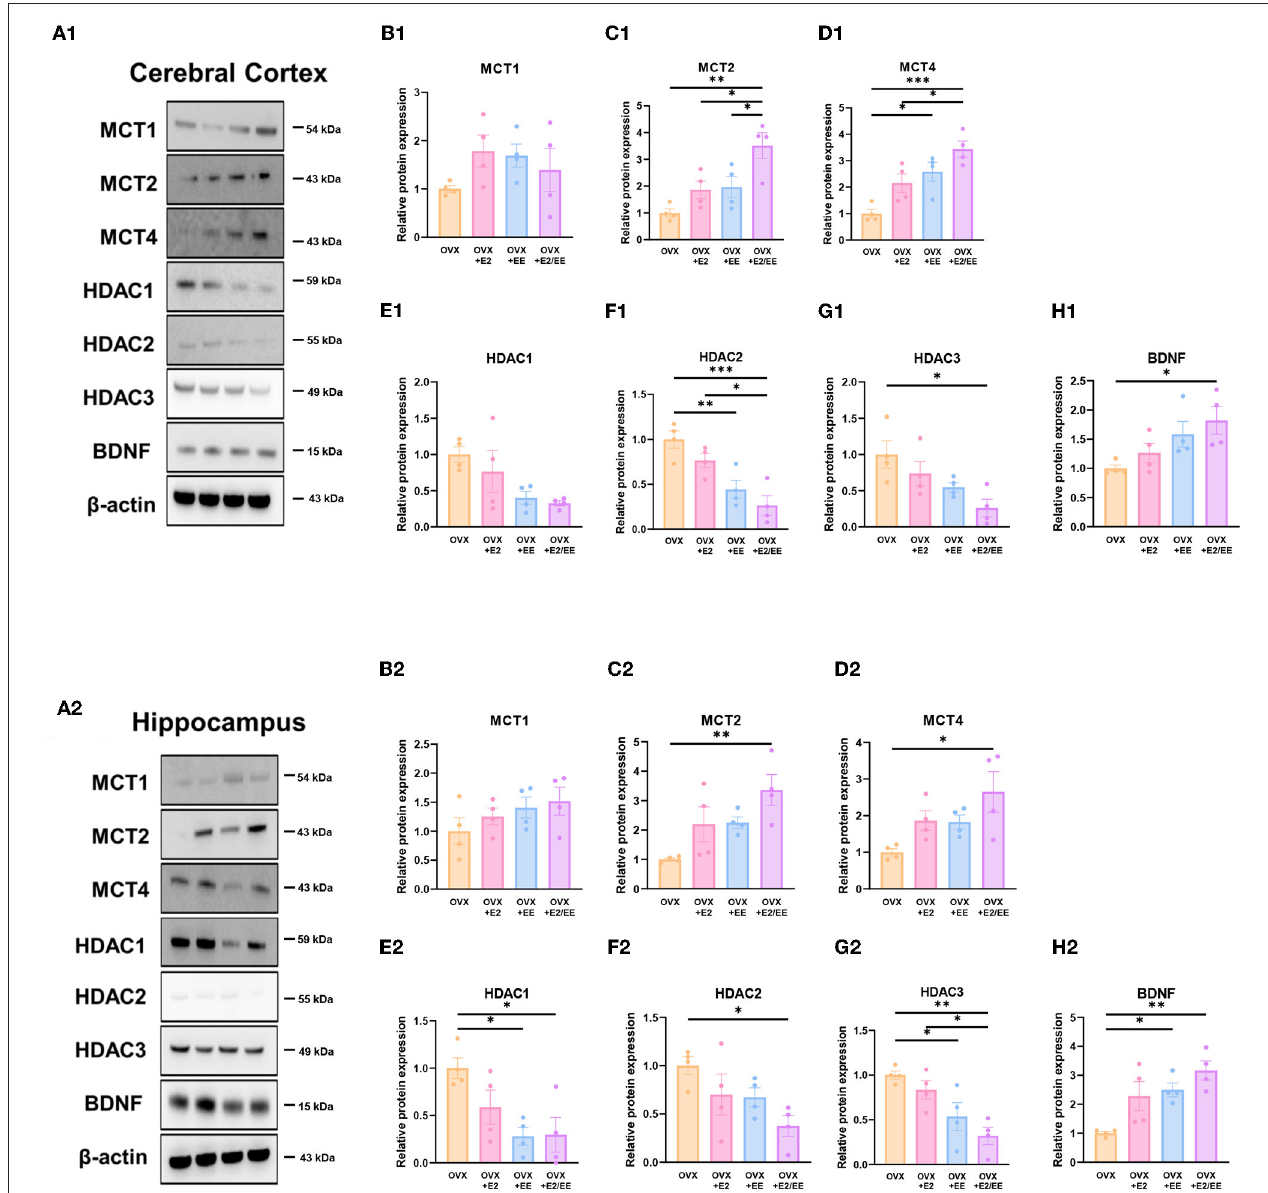
FIGURE 11 | Synergistic effects of estrogen and EE on the expression of ketone-related proteins by western blot. (A1–H1) Cerebral cortex and (A2–H2) hippocampus protein levels for β HB-related proteins measured using western blot ( n = 4 per group). One-way ANOVA with Tukey multiple comparison test. Data represented are means ± SEM. * p < 0.05, ** p < 0.01, and *** p <